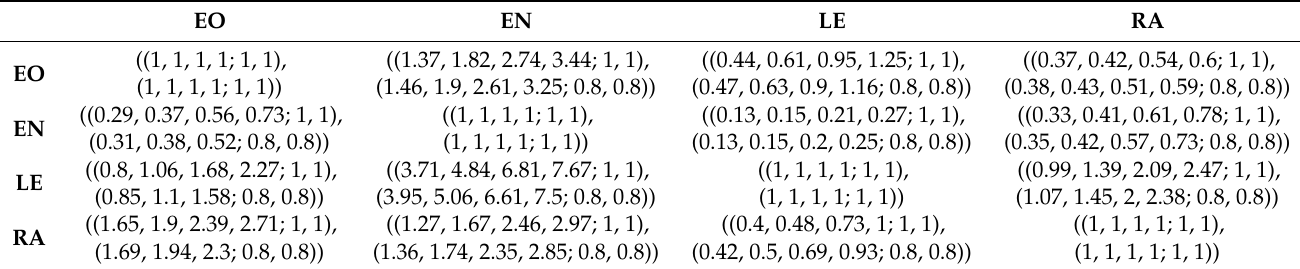
Table 3. Pairwise IT2F comparison matrix—Performance factors.